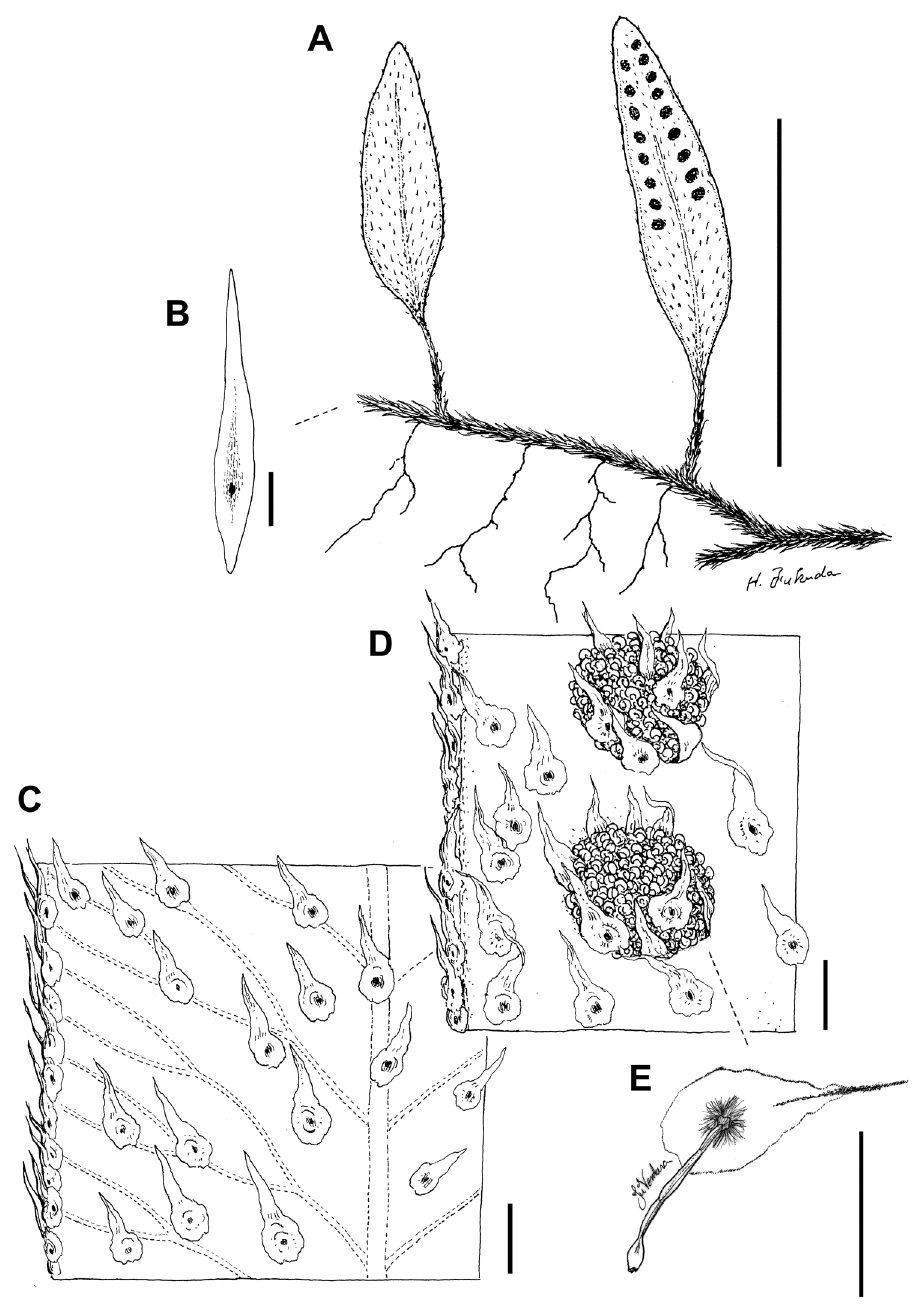
Figure 2. Adetogramma chrysolepis (Hook.) T.E.Almeida. A Habit B Rhizome scale C Sterile lamina de- tail showing free venation and laminar scales D Fertile lamina detail showing sori, paraphyses, and laminar scales E Paraphysis detail. Drawings A–D by H. Fukuda from Dorr et al. 6764 (NY); drawing E by Juliana Ventura from T.E. Almeida & L.L. Giacomin 3121 (BHCB). Scale bars: A = 5 cm, B–E = 1